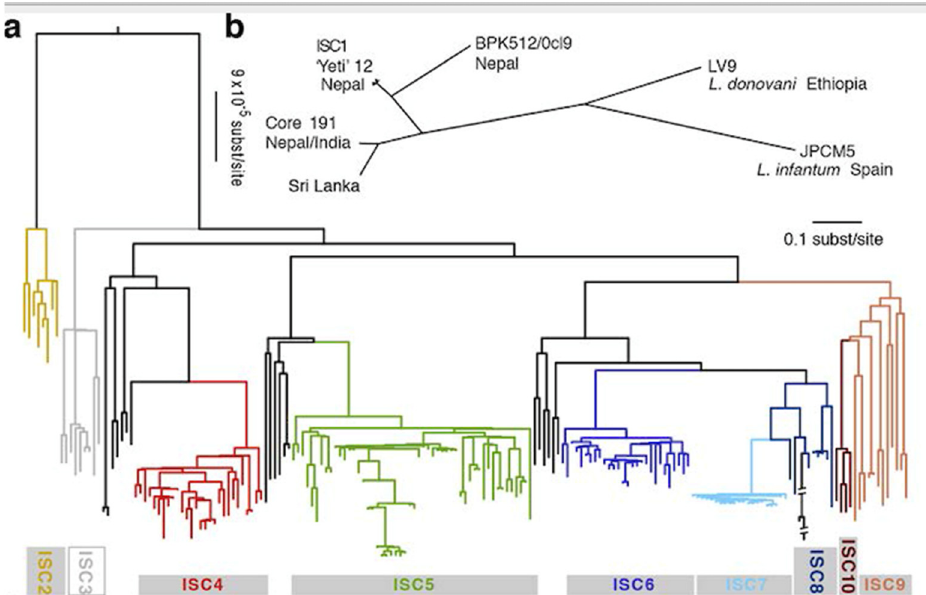
Figure 2. Various lesser NCs (ISC1 to 10) evidenced within one microsatellite MLG (Core 191 in Nepal and India, top right of the figure) of the L. donovani/infantum complex by genomic analysis. a = SNP-based phylogenetic tree. b = Unrooted phylogenetic network of the complex based on genetic distances between isolates described here (after [46]).